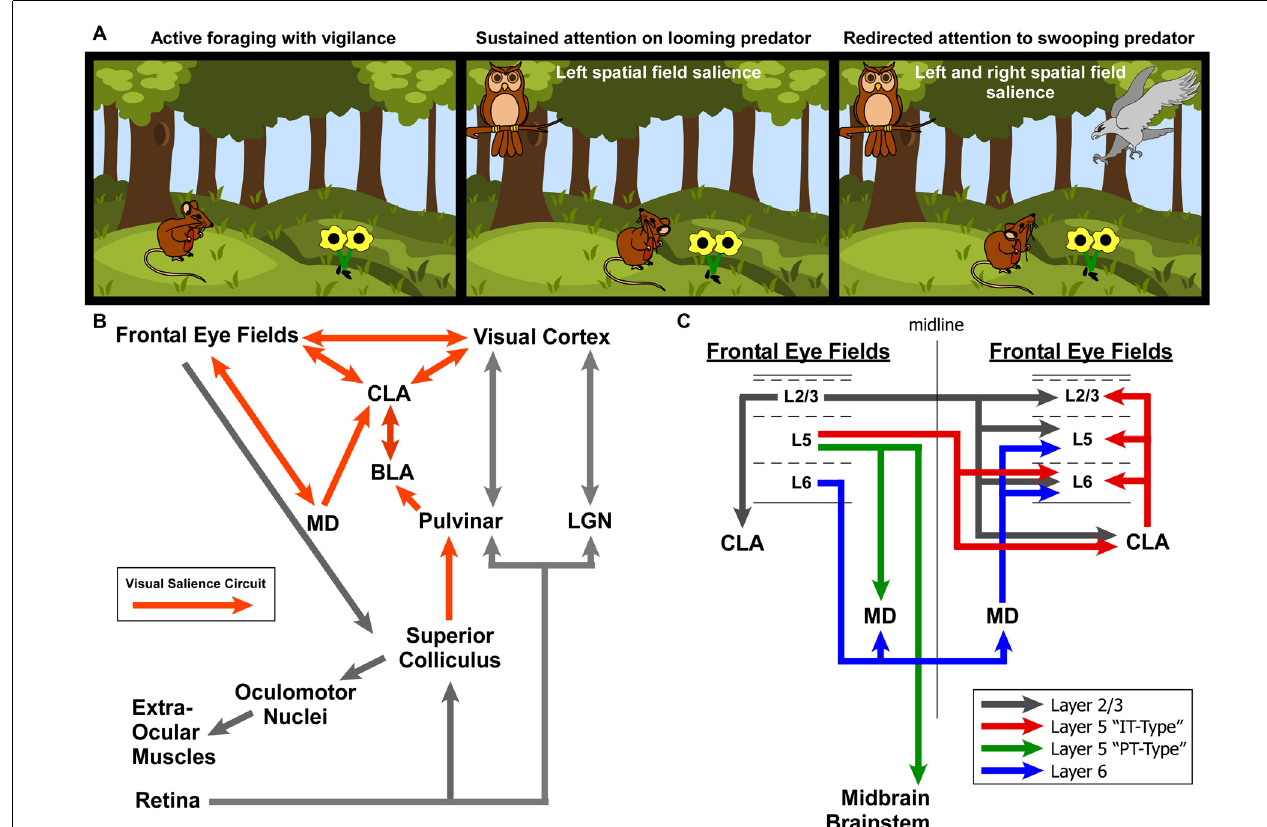
FIGURE 9 | Role for the claustrum in processing visual salience. (A) Illustration of ethologically relevant scenario involving rodent vision to orient to predatory salient stimuli while otherwise attempting to actively forage. If predators are in different spatial fields, interhemispheric mechanisms are needed to coordinate attention to these stimuli across disparate visual fields. (B) Circuit diagram of the ascending visual processing pathway from the retina and the descending visuomotor pathway for controlling the extra-ocular muscles. Note the proposed “visual salience circuit” emanating from the superior colliculus and relayed to limbic structures (BLA and subsequently CLA) via the pulvinar. (C) Summary of interhemispheric connections between the rodent frontal eye fields. Summarized from findings from Alloway et al. (2008), Smith and Alloway (2010, 2014) and Smith et al. (2012, 2016,